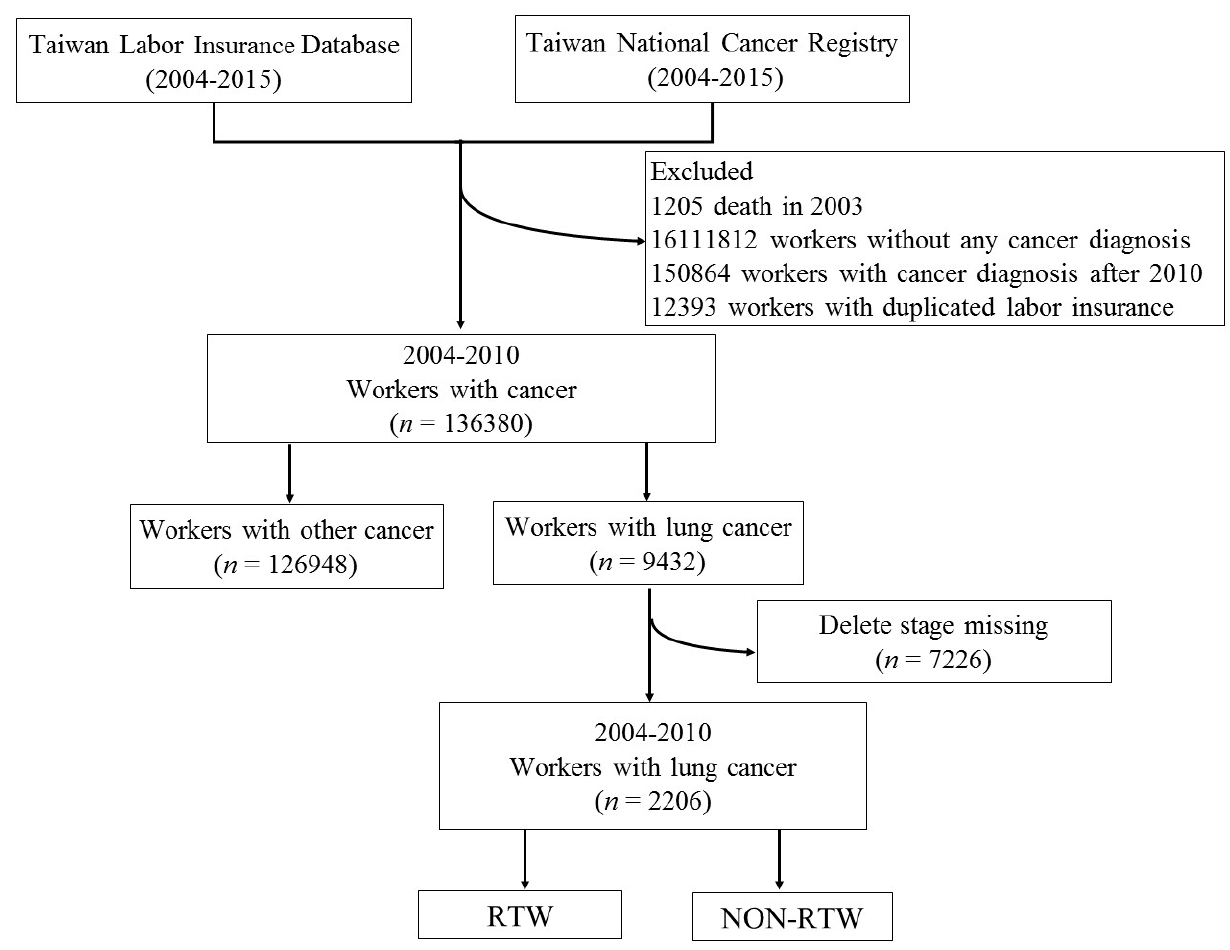
Figure 1. Flow chart of study population.